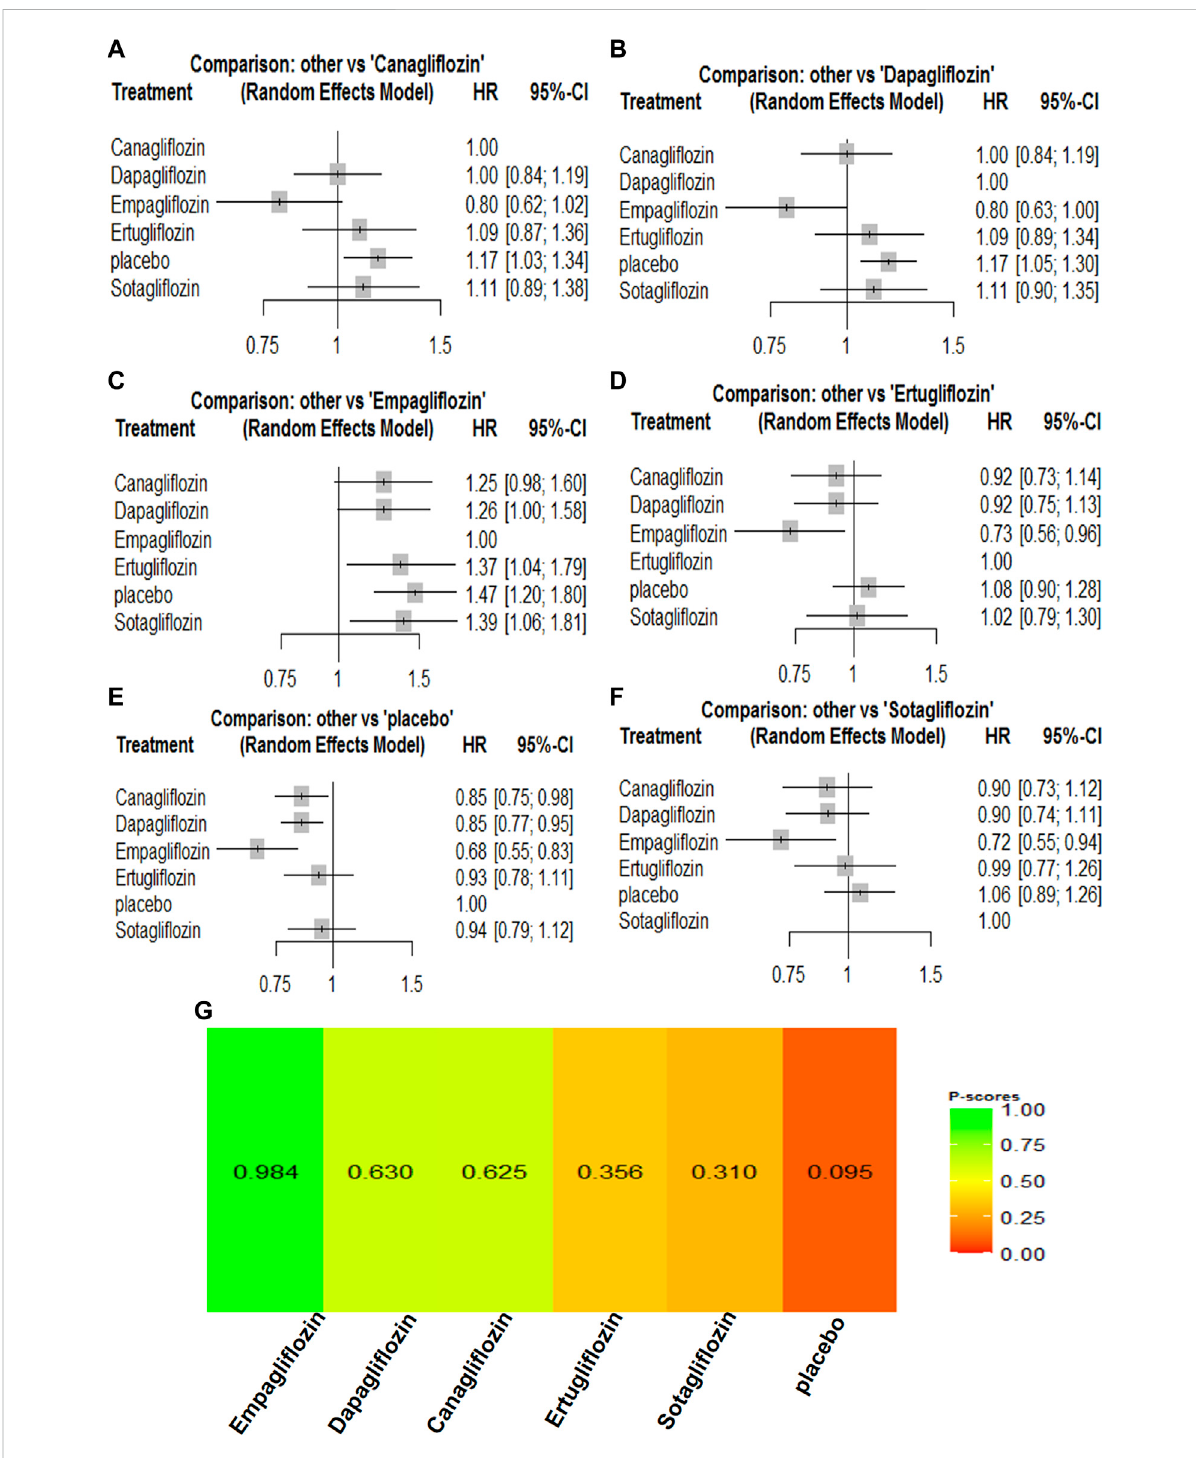
FIGURE 2 Forest Plots and Ranking Plots of Network Meta-analysis of all trials for All-cause Mortality. (A) Forest Plots of other drugs compare to canagli fl ozin. (B) Forest Plots of other drugs compare to dapagli fl ozin. (C) Forest Plots of other drugs compare to empagli fl ozin. (D) Forest Plots of other drugs compare to ertugli fl ozin. (E) Forest Plots of other drugs compare to placebo. (F) Forest Plots of other drugs compare to sotagli fl ozin. All outcomesareexpressedashazardratios(HRs)fortreatmentvsthecomparatorand95%credibleintervals(95%-CI).Forexample,theHRsinall- cause mortality for dapagli fl ozin compared to canagli fl ozin is 1.00 (95%-CI 0.84 to 1.19). The x-axis scale indicates the range of the HRs. (G) Ranking Plots of Network Meta-analysis. Plots below the forest plots show for the rank of each drug class and ranking descending from left to right, The p- score represents the power of the